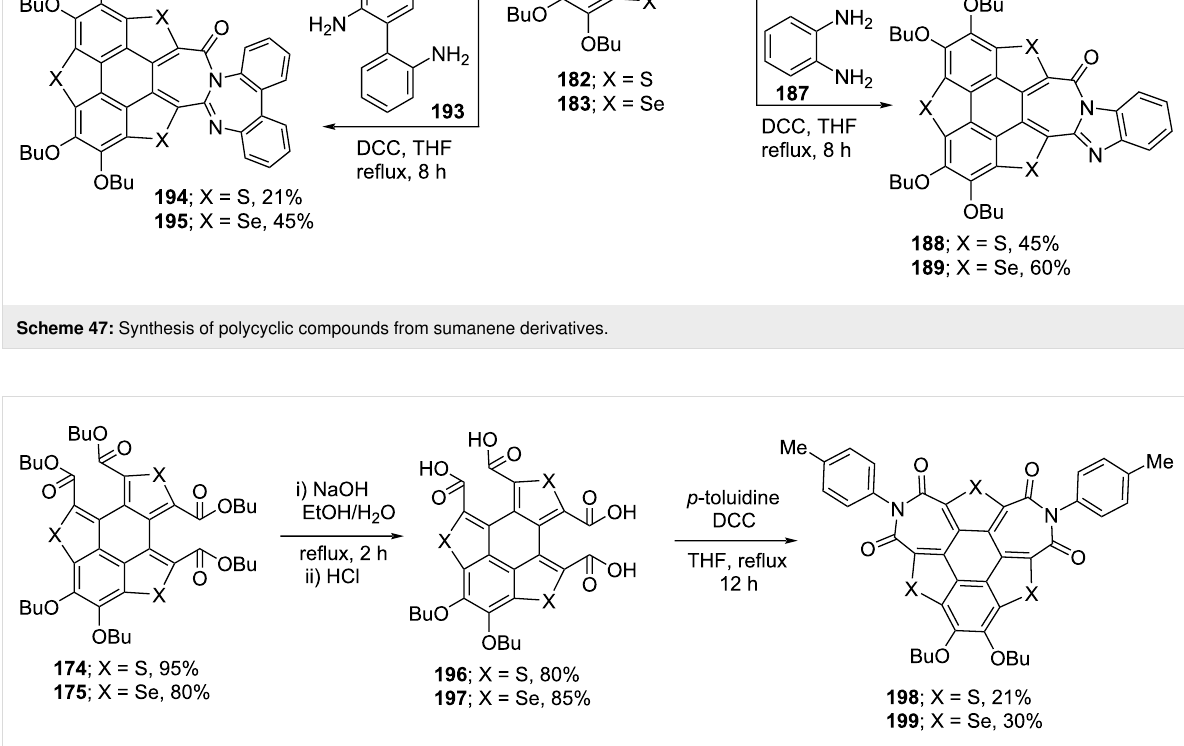
Scheme 48: Synthesis of diimide-based heterocycles reported by Shao’s and co-workers.